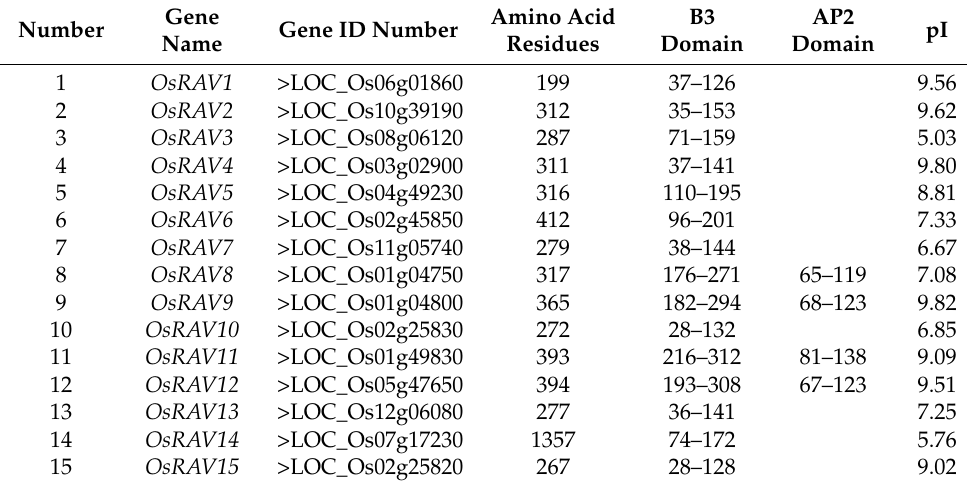
Table 1. Properties of the rice RAV proteins identified, including sequence ID and predicted sequence